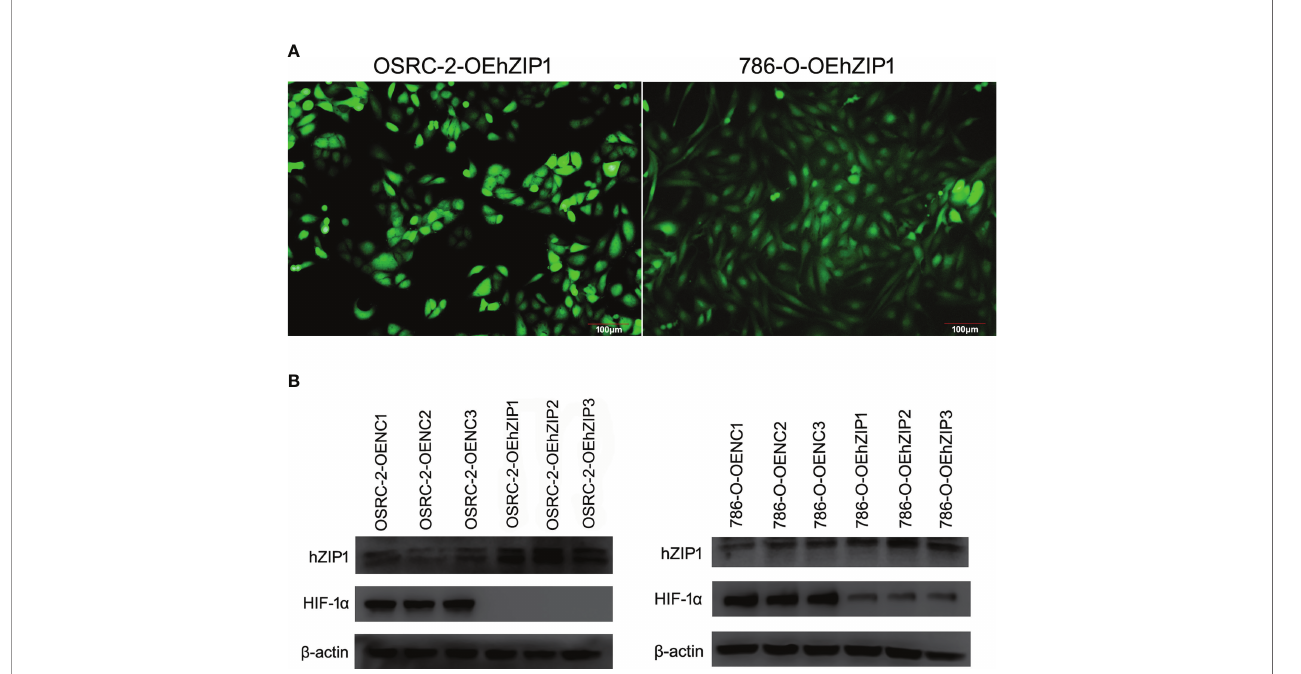
FIGURE 5 | Overexpression of hZIP1 inhibited the expression of HIF-1 a . (A) Fourteen days after the lentiviral transfection, the OSRC-2/786-O cells were successfully overexpressed with hZIP1 under a fl uorescent inverted microscope. (B) We stably transfected the OSRC-2 cells/786-O cells with hZIP1 lentivirus, and changes in HIF-1 a protein levels were obtained by western blot analysis and compared with those in cells stably transfected with negative control lentivirus (P